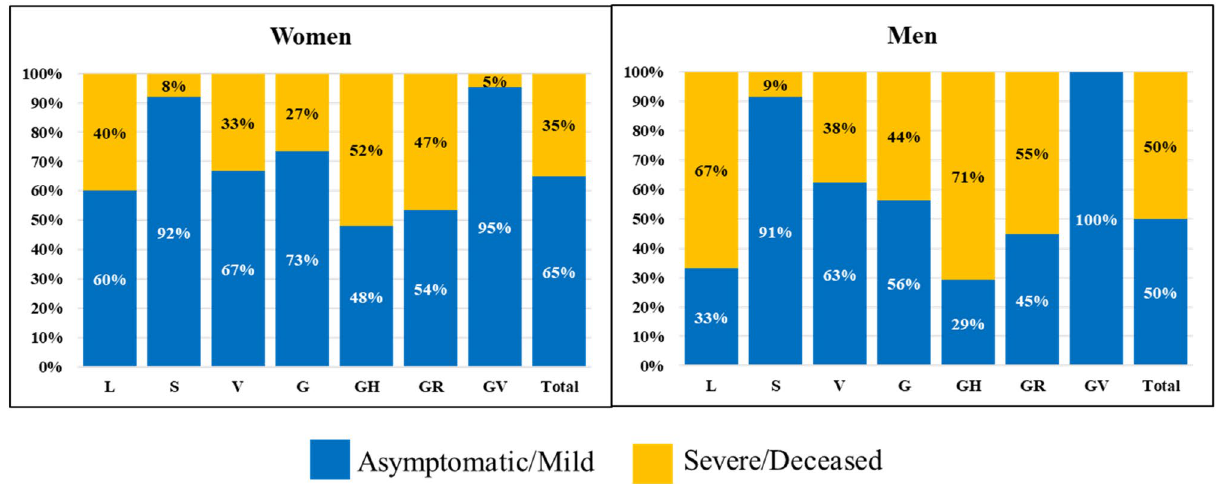
Figure 3. Clinical status of patients infected by SARS-CoV-2 of different clades in different gender groups.